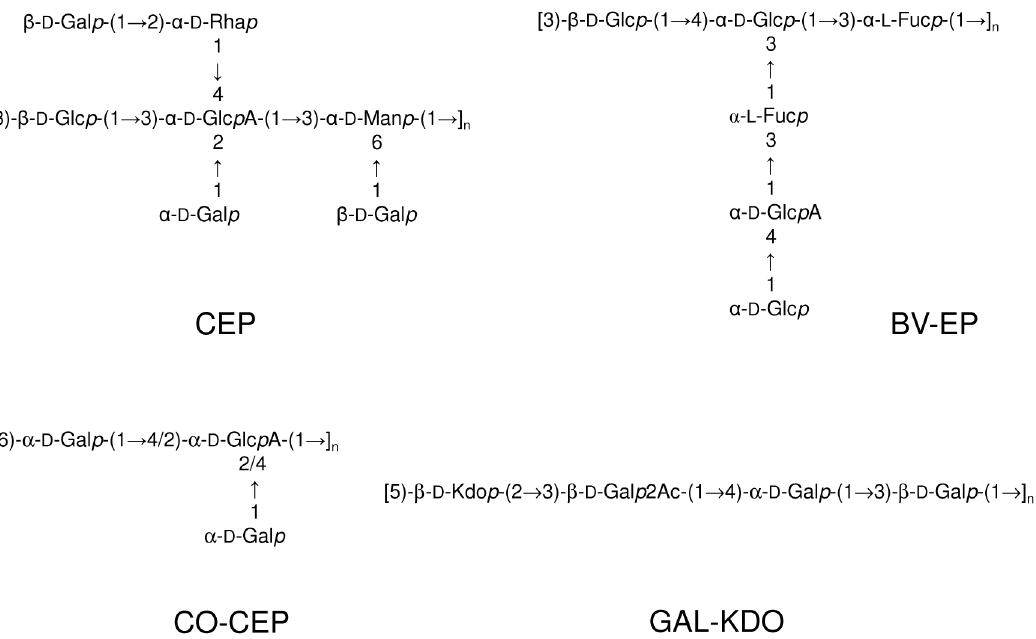
Figure 1. Repeating units structure of exopolysaccharides produced by BCC species. Primary structures of the repeating units of the exopolysaccharides CEP , GAL-KDO , BV-EP and CO-CEP . graphs. The anomeric region of the 1 H-NMR spectrum (Figure 2c) was rather crowded, but the resonances of CEP were clearly visible. On the contrary, the anomeric protons of GAL-KDO were not well resolved, since they partially overlapped with H-1 of 3-linked Glc of CEP and with other resonances due to acetylation.